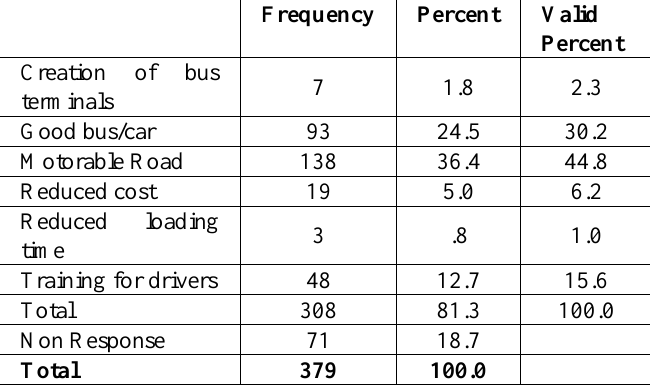
Table 7: Improvement needed to make public